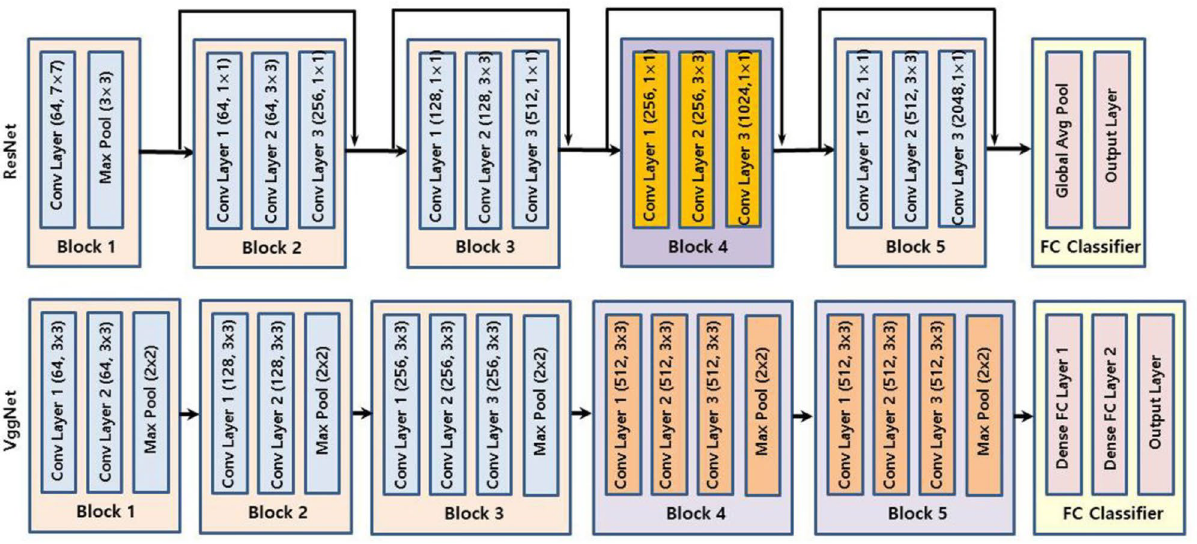
Figure 2. Basic structures of ResNet and VggNet models. By utilizing skip connections in ResNet, the degradation problem can be diminished. VggNet has simple structures such that the depth of the network can be increased to achieve better